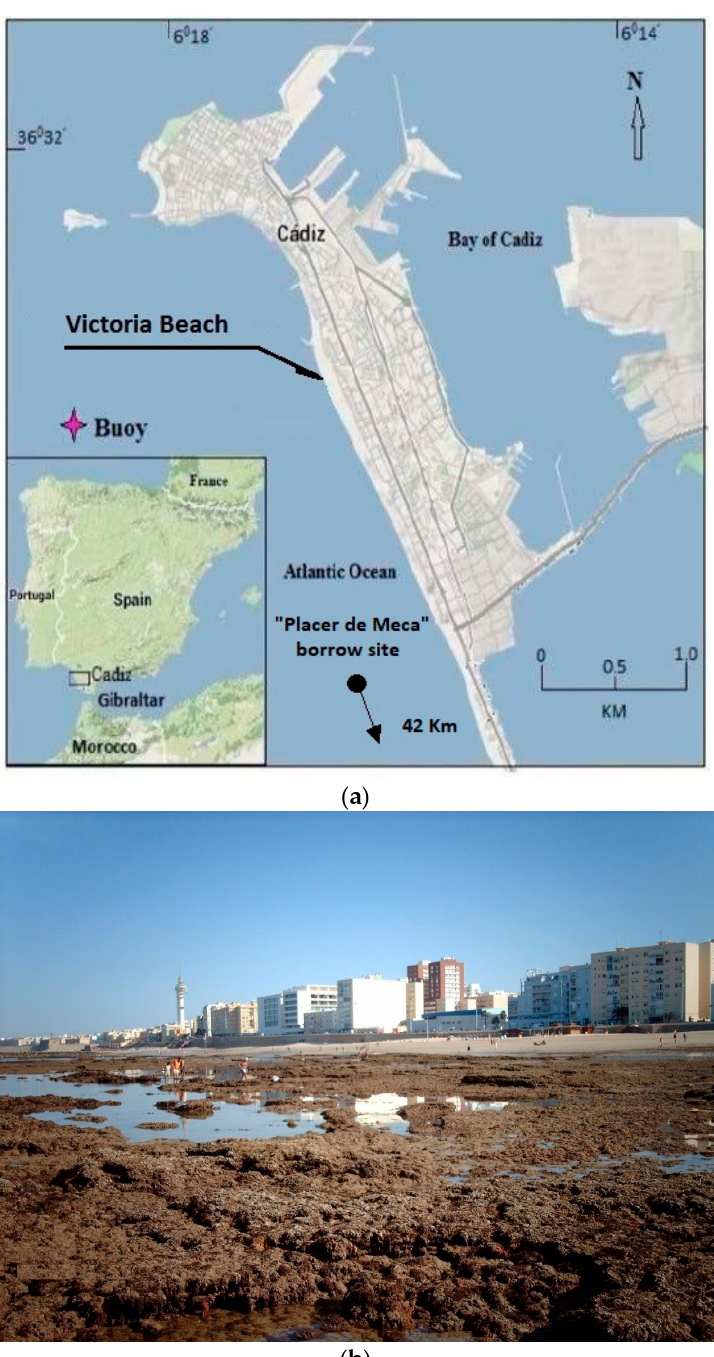
Figure 2. Location of Victoria Beach (VB) and indication of the borrow site (named Placer de Meca) in Cadiz, SW Spain, ( a ); and a ground view of the reef platform ( b ) (source: Muñoz-Perez, 2009). Table 1. Comparison between Royal Hawaiian Beach (RHB) and Victoria Beach (VB) characteristics.